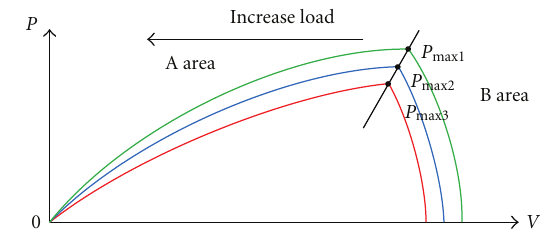
Figure 5: Block diagram of battery charger.